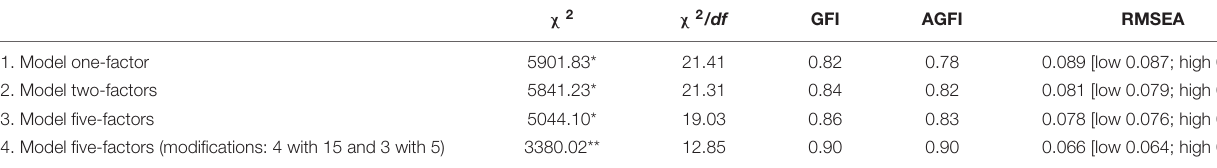
TABLE 2 | Fit index for assessed